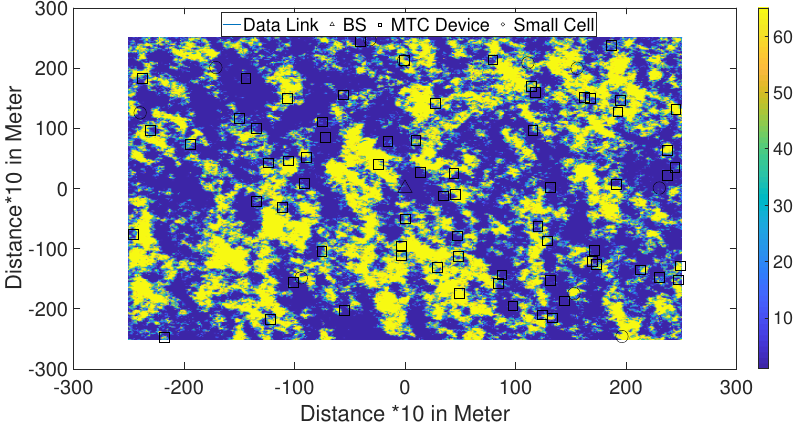
Figure 2. Applying Shadow Fading Map to our simulation